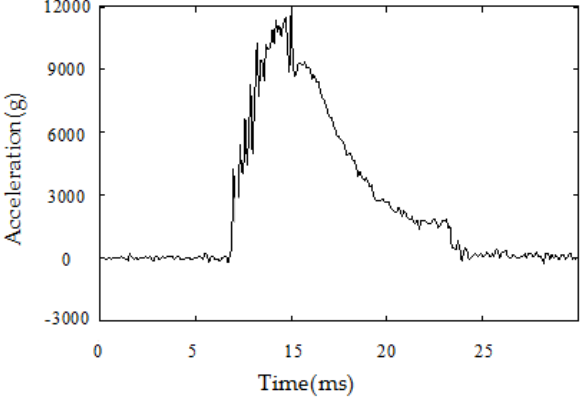
Figure 3. The in ‐ bore acceleration of a 122 mm extended ‐ range guided projectile.